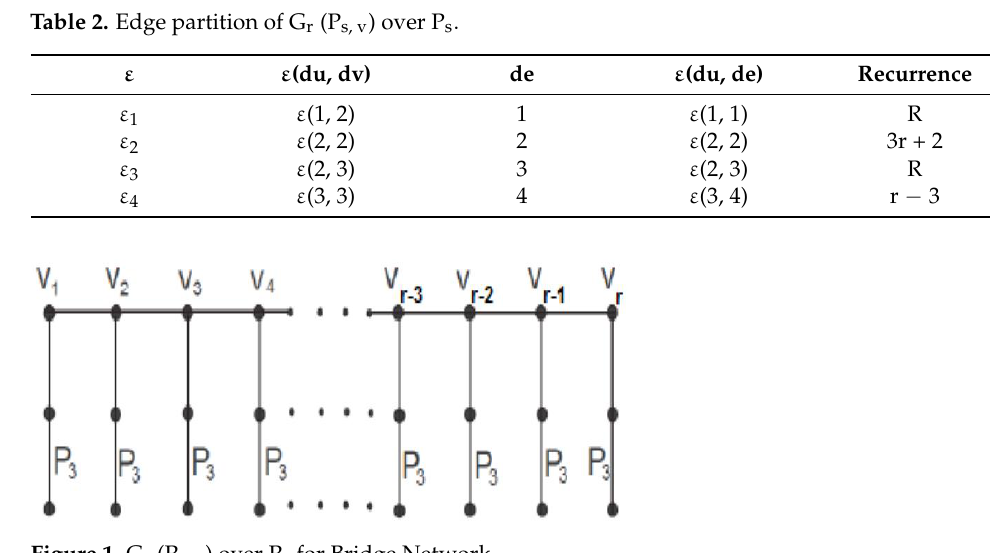
Figure 1. G r (P s , v ) over P s for Bridge Network . Figure 1. G r (P s, v ) over P s for Bridge